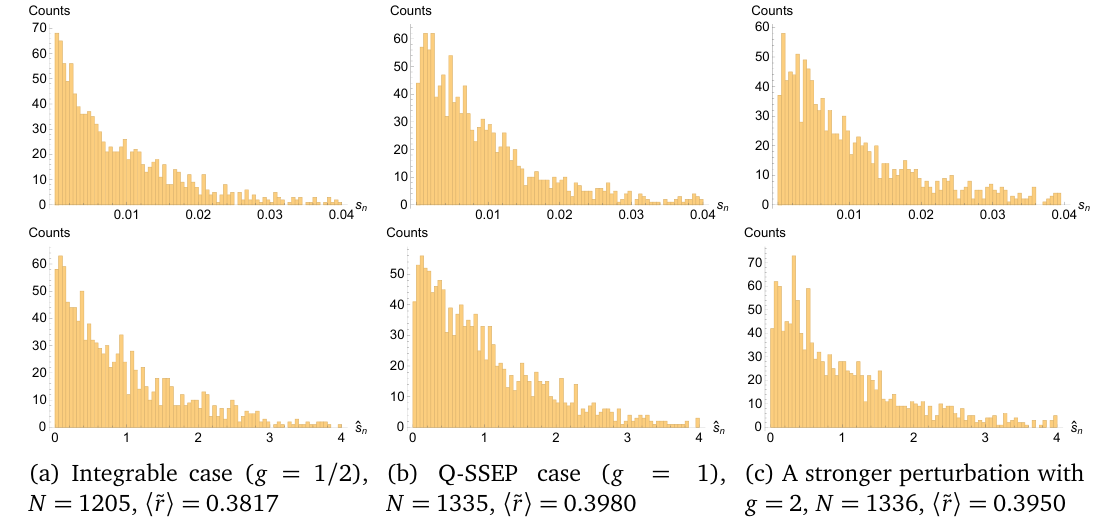
Figure 2: Histograms of the spacings between consecutive raw eigenvalues (first row) and unfolded eigenvalues (second row) for a deformation of the Q-SSEP Linbladian for quadratic fluctuations on L = 10 sites in the c parametrised by g and defined as L ( g ) ∝ corresponds to the original Q-SSEP case. The chosen symmetry sector is defined by k = 2 π/ 10 and Cartan charges ( J z the number of eigenvalues left after removing the